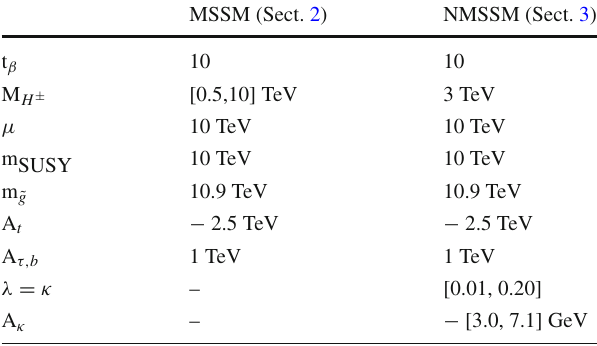
Table 1 Input parameters for the studied scenarios MSSM (Sect. 2) NMSSM (Sect.